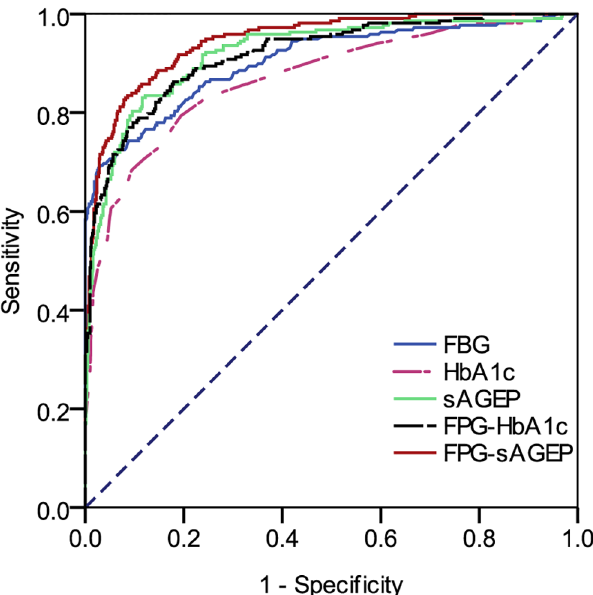
Fig 2. The ROC curves generated by the logistic regression models on FPG, HbA1c, sAGEP, FPG-HbA1c and FPG-sAGEP. ROC, receiver operating characteristic; FPG, fasting plasma glucose; HbA1c, glycated haemoglobin A1c; sAGEP, serum advanced glycation end products-peptides; FPG-HbA1c, FPG plus HbA1c; FPG-sAGEP, FPG plus sAGEP. The areas under the ROC curves for FPG, HbA1c, sAGEP, FPG-HbA1c and FPG-sAGEP were 0.772, 0.838, 0.894, 0.845, and 0.899, respectively. Comparisons among these areas were as follows: FPG-sAGEP vs. FPG-HbA1c ( P = 0.0003), FPG-sAGEP vs. sAGEP ( P = 0.58), FPG-sAGEP vs. HbA1c ( P < 0.001), FPG-sAGEP vs. FPG ( P < 0.001), FPG-HbA1c vs. FPG ( P < 0.001), sAGEP vs. HbA1c ( P = 0.006), sAGEP vs. FPG ( P <